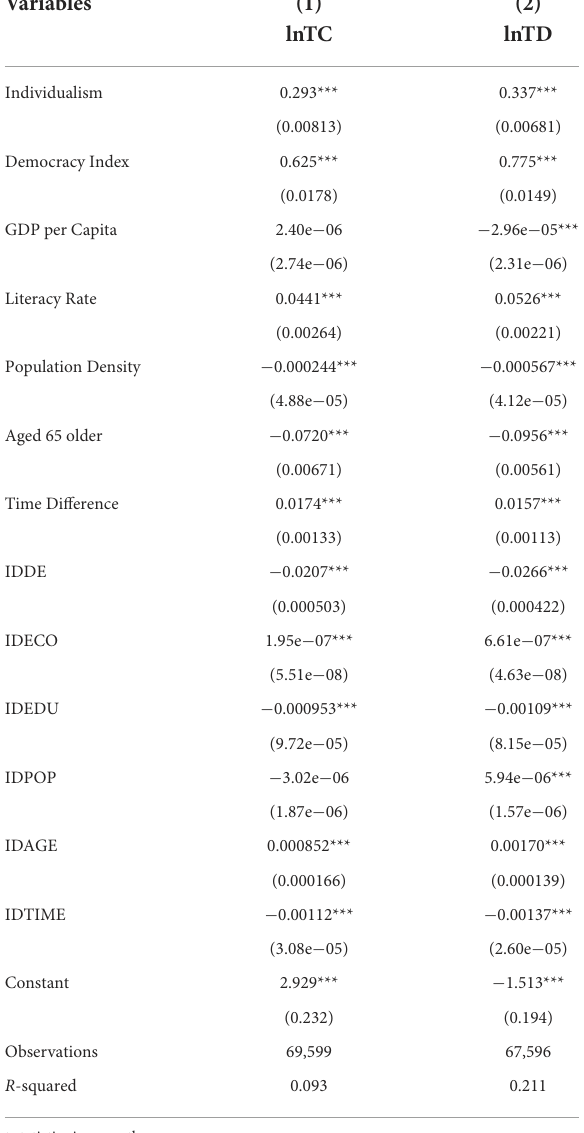
TABLE 7 Moderating effect of control variables on total